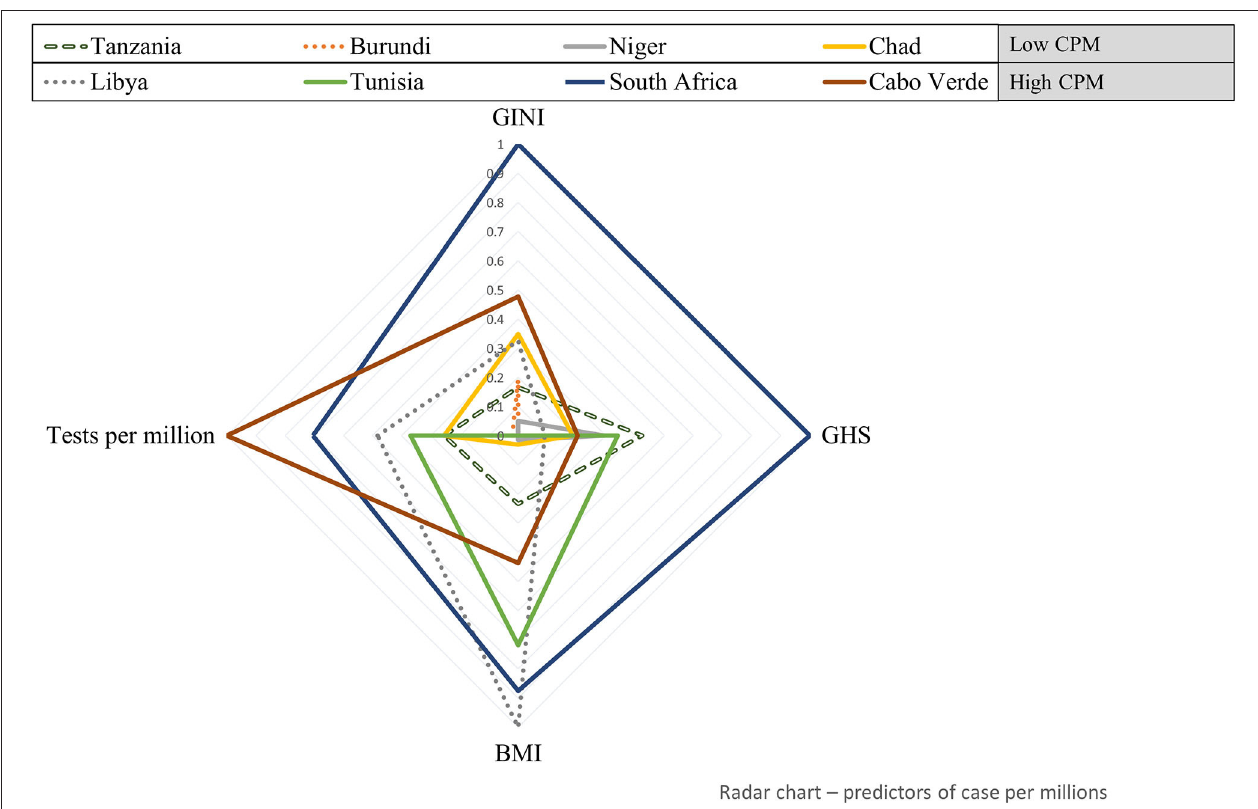
FIGURE 1 | Health system, socio-economic, and clinical factors’ profile of eight African countries with a wide range of COVID-19 cases per 1 million populations. Standardized values of variables significantly associated with COVID-19 cases per 1 million populations (test per millions, GINI, global health security [GHS], and body mass index [BMI]) are plotted for eight countries having the lowest (upper-left) to highest (lower-right) COVID-19 cases per million. CPM, Cases per 1 million